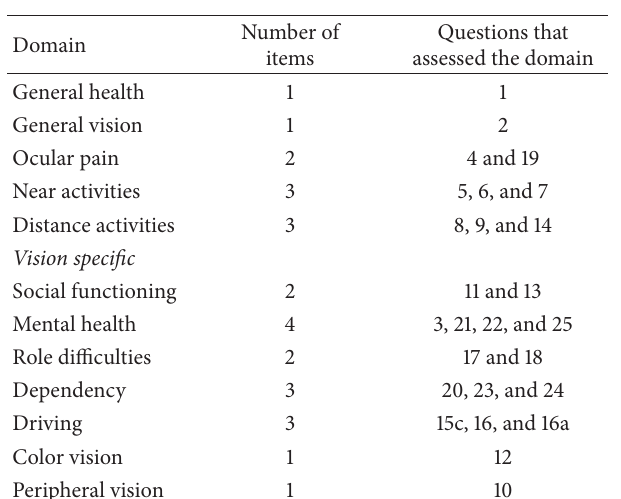
Table 1: Domains considered in the NEI VFQ-25. The table reports the domains considered in the VFQ-25, the number of items considered in each domain, and their respective questions.